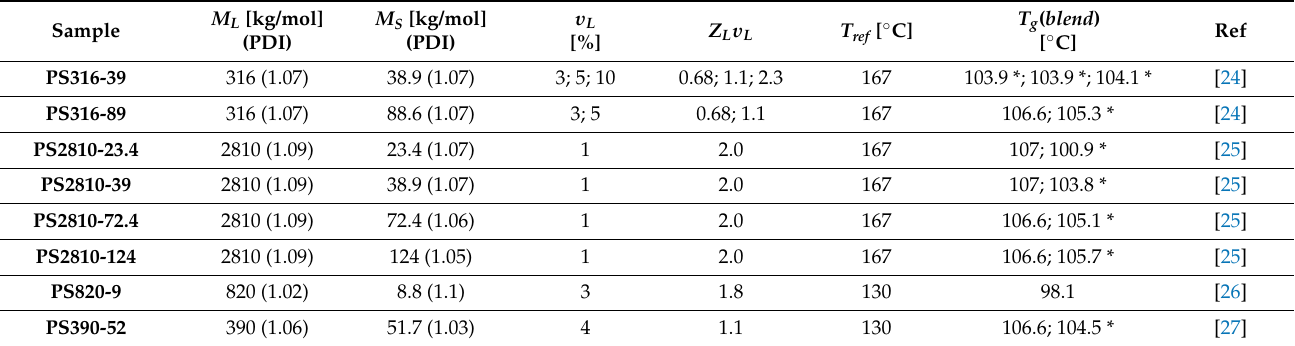
Table 3. Bidisperse PS samples.